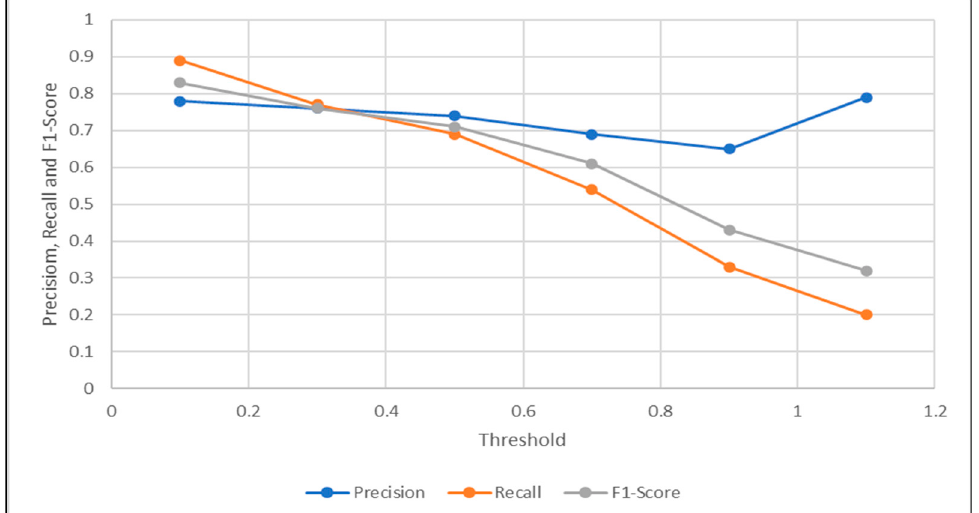
Figure 3. Optimal Threshold Selection Using Regular Signal Difference.